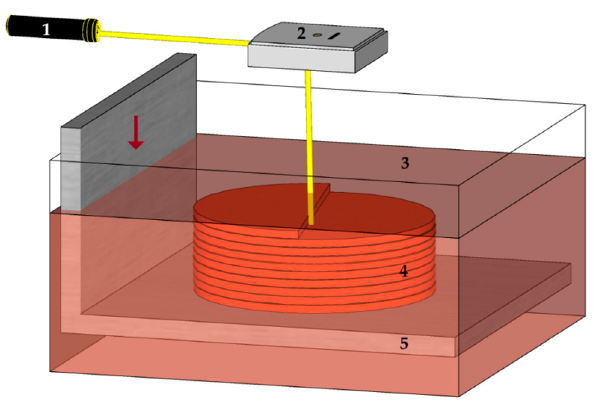
Figure 5. Vat Photopolymerization-based Stereolithography: 1—laser, 2—scanner, 3—vat of resin, 4—part (cured resin), 5—stage.